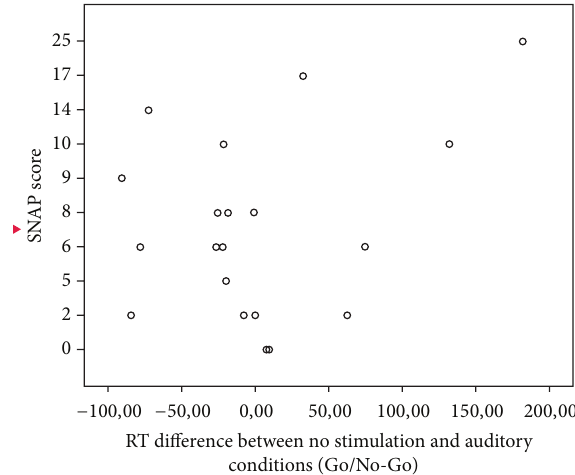
Figure 2: Correlation between SNAP scores and the differences between baseline and auditory stimulation for reaction times in the Go/No-Go